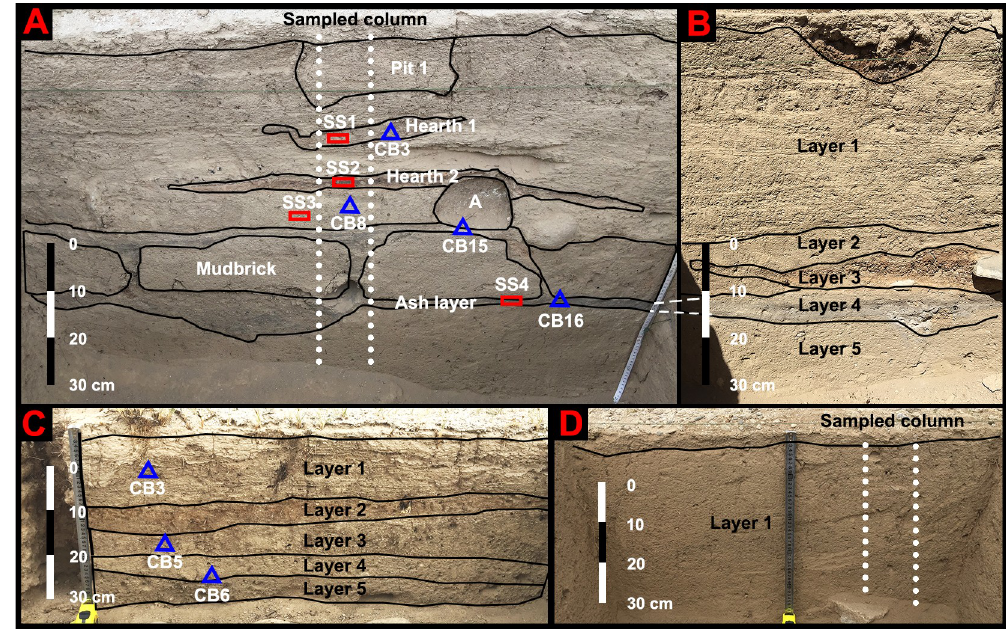
Fig 5. Test trench profiles examined in this study. (A) the northern profile of T2-House 3. (B) the eastern profile of T2-House 3. (C) the southern profile of T1-House 2. (D) the western profile of T5-Field